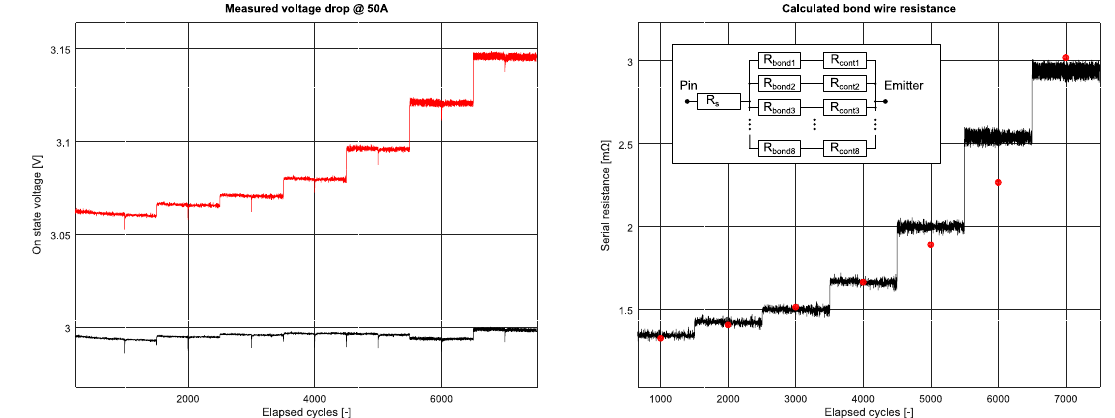
Figure 15. Measured device voltage at CH1 (red) and CH2 (black) at 50A load current, as the function of the elapsed power cycles ( left ); measured bond-wire resistances (black), a simple bond-resistance model, and the resistance steps calculated from the model (red dots) ( right ).